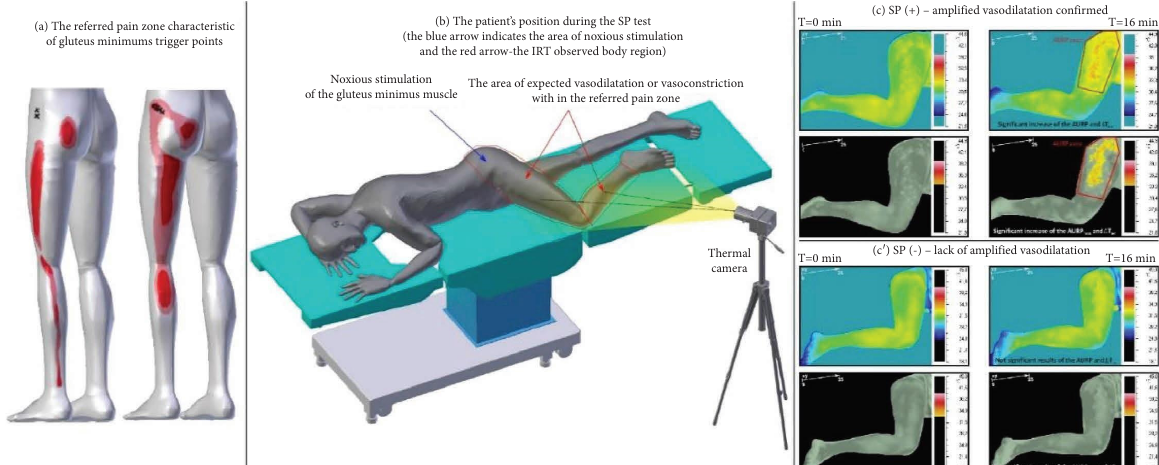
Figure 1: An illustration of the SP test ® applied to latent trigger points of healthy subjects: (a) the referred pain zone characteristic of gluteus minimus trigger points; (b) the patient’s position during the SP test ® (the blue arrow indicates the area of gluteus minimus noxious stimulation and the red arrow shows the body region, that is, coincident with the gluteus minimus referred pain zone, and that was observed for possible autonomic reactivity using an infrared thermal camera; (c) an example of an LTrPs patient’s response to the SP test ® ; (c ′ ) an example of a healthy subject’s response to the SP test ® .